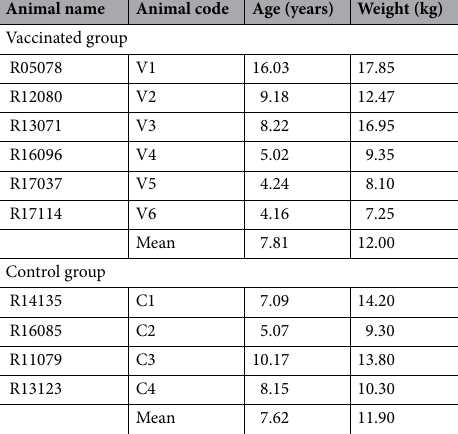
Table 1. Animal name, age and weight at the start of the